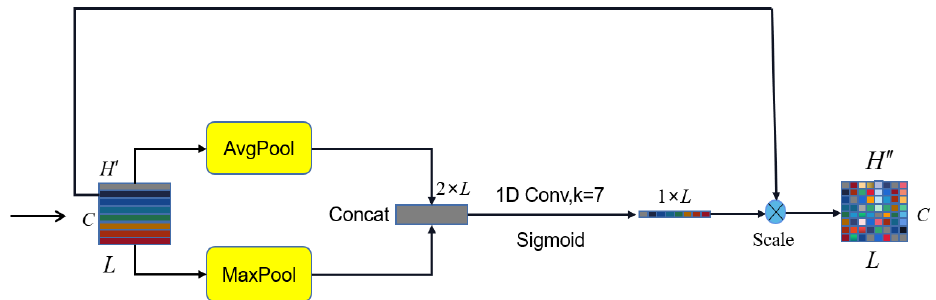
Figure 7. The structure of the temporal